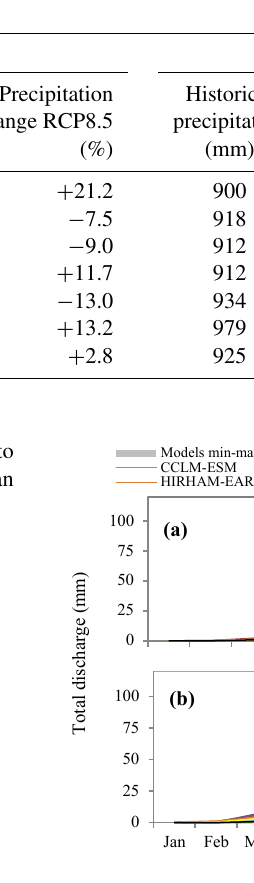
Table 3. Projected rainfall change between the reference (1971–2000) and future (2021–2050) periods with bias corrected and non bias corrected RCM–GCM based simulations.